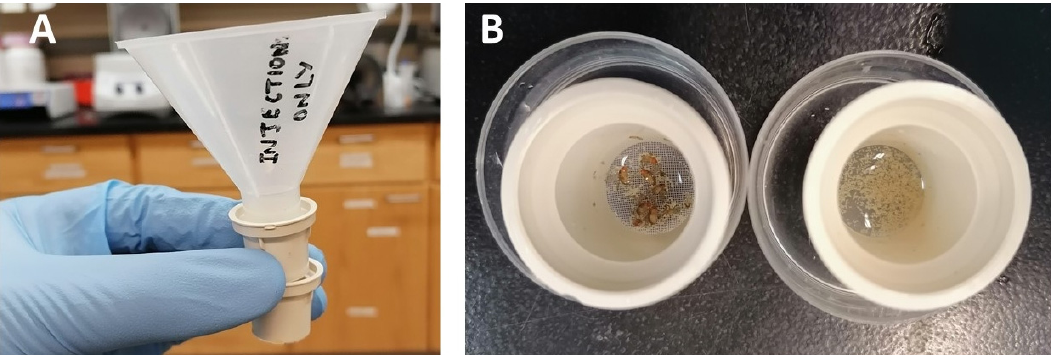
Figure 3. Egg collection with a funnel and two filters. ( A ) The funnel is placed on top of the coarse filter, and the fine filter is held underneath to collect the eggs. ( B ) The coarse filter (left) mainly traps the flies and sponge fibers, while the fine filter (right) retains the eggs.